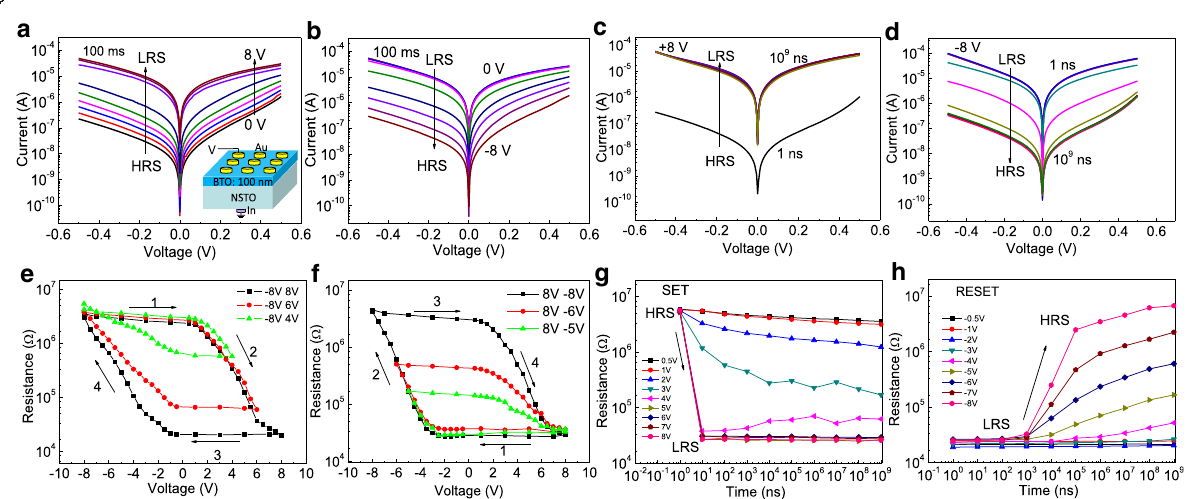
Fig. 1 The current-voltage curves of the Au/BTO/NSTO/In system at small biases between − 0.5 and 0.5 V after applying a pulse in width of 100 ms with various amplitudes ( a , b ). The current-voltage curves of the Au/BTO/NSTO/In system at small biases after applying a pulse with an amplitude of + 8 V ( c ) and − 8 V ( d ) with various pulse widths. The junction resistance of the Au/BTO/NSTO/In system recorded at − 0.3 V after the application of voltage pulses with various amplitudes and widths starting from the HRS ( e , g ) or LRS ( f , h ), where the pulse widths in e and f are 100 ms and the different curves in e and f correspond to different consecutive measurements, with varying positive or negative maximum voltages. The inset of a shows the schematic drawing of the device